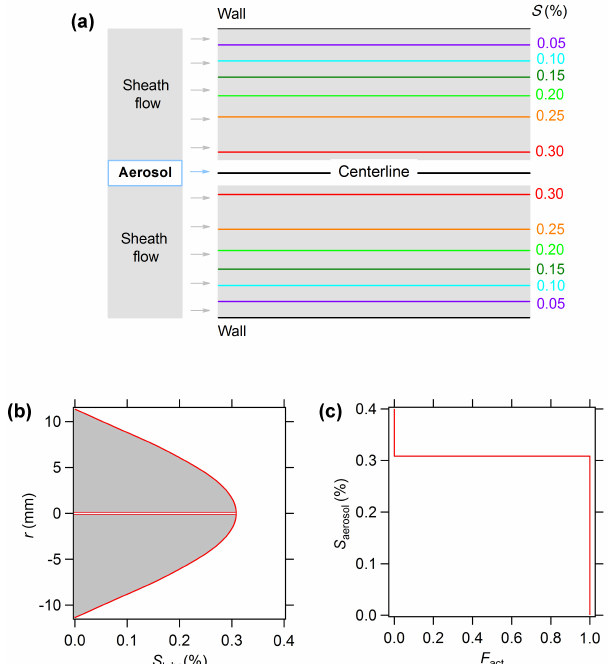
Figure 1. Schematics of typical CCN measurements. (a) Contour of supersaturation in the CCN activation unit and configuration of aerosol and sheath flow; (b) distribution of supersaturation in the activation unit ( S tube ) . r is the radial distance to the centerline. The shaded areas represent the sheath flow part, and the non-shaded ar- eas represent the aerosol flow part. The S tube profile is adopted from http://nenes.eas.gatech.edu/Experiments/CFSTGC.html. (c) Plot of the activation supersaturation of aerosol particles S aerosol against the activation fraction F act